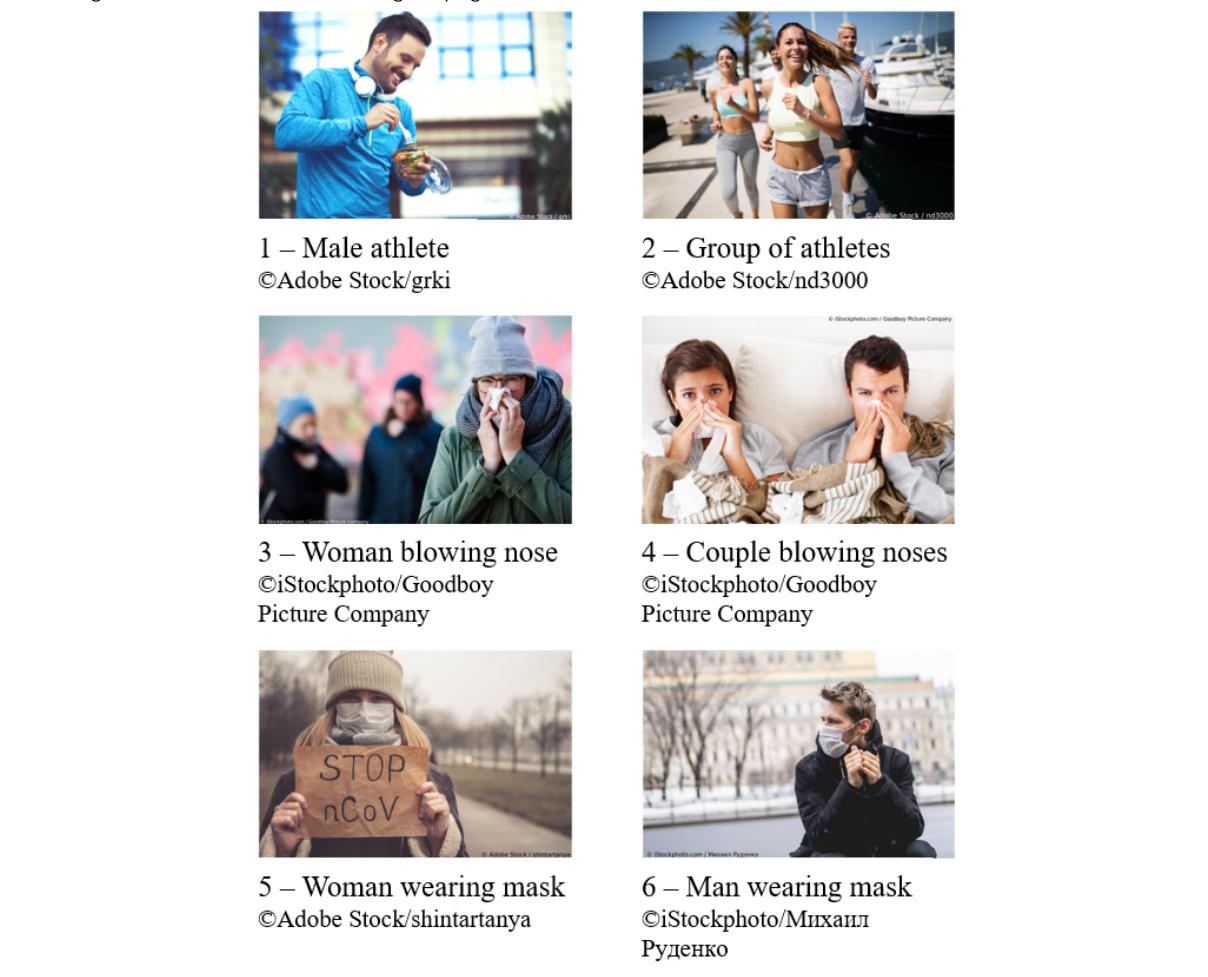
Figure 5. Images used in the Facebook advertising campaigns.